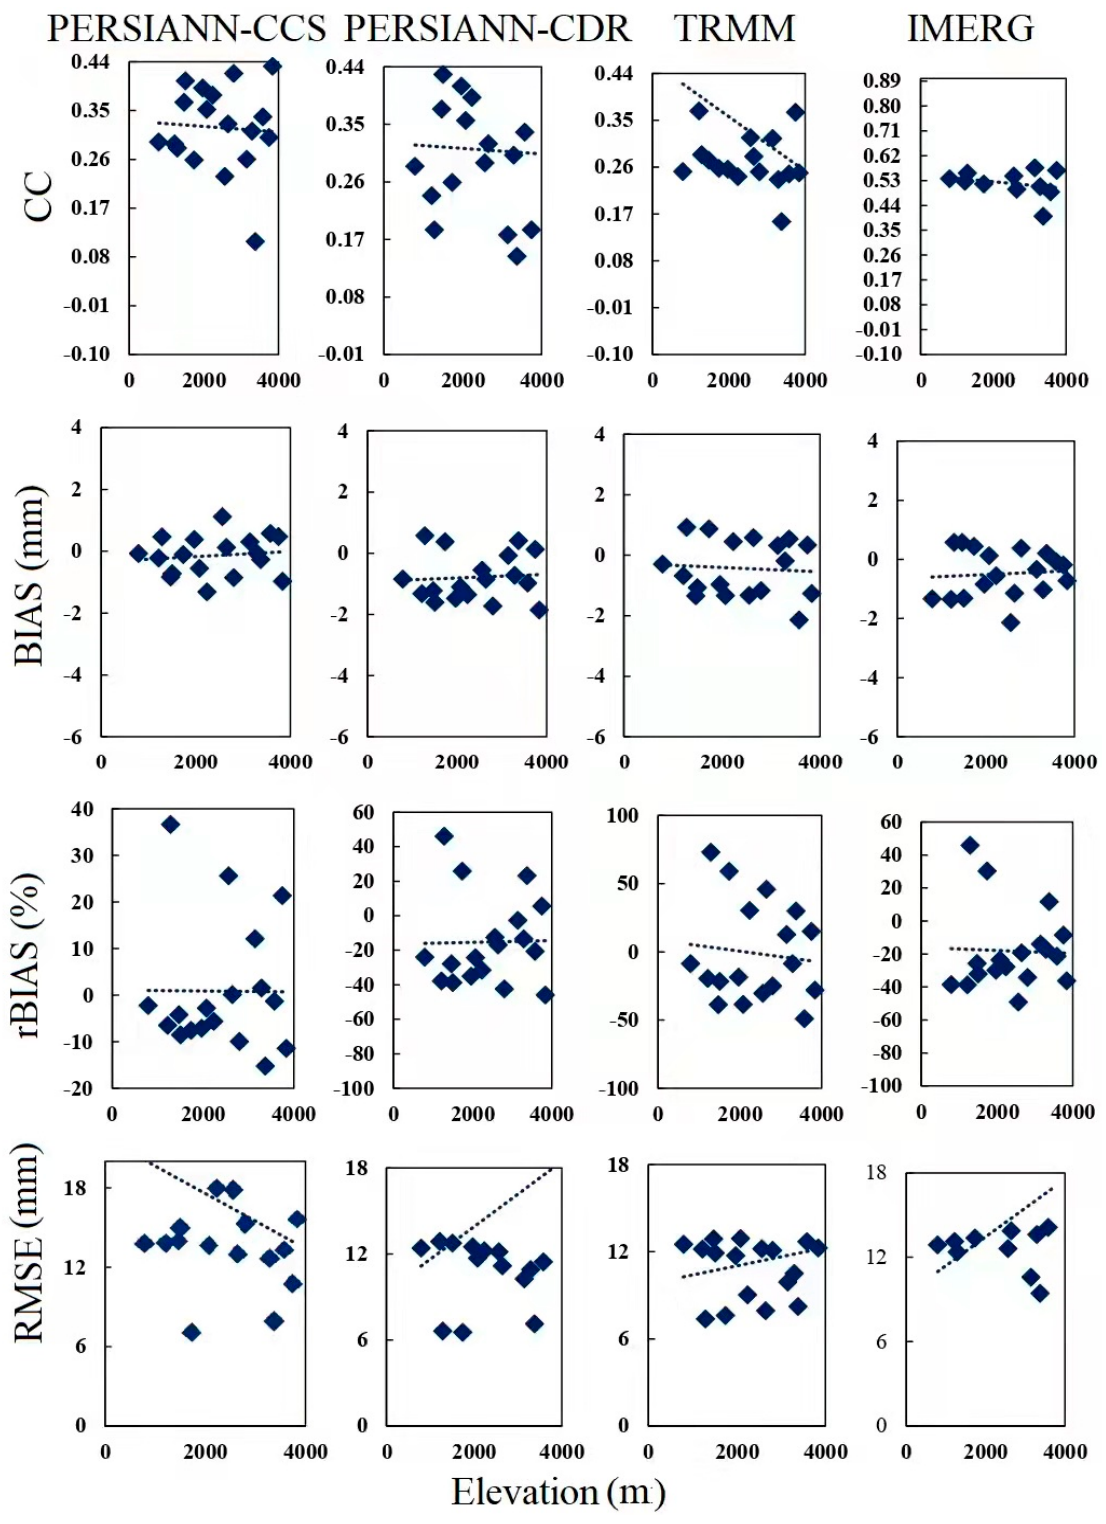
Figure 10. Impact of elevation on daily estimations of evaluation indices. A comparison of the performance of all SBPD and in situ observations at a daily scale is illustrated in the Taylor diagram (Figure 11). For the generation of the Taylor diagram [32], all daily estimations of (gauge, TRMM, IMERG, PERSIANN-CDR, and CCS) were normalized. The blue lines showing the CC values of all datasets indicated